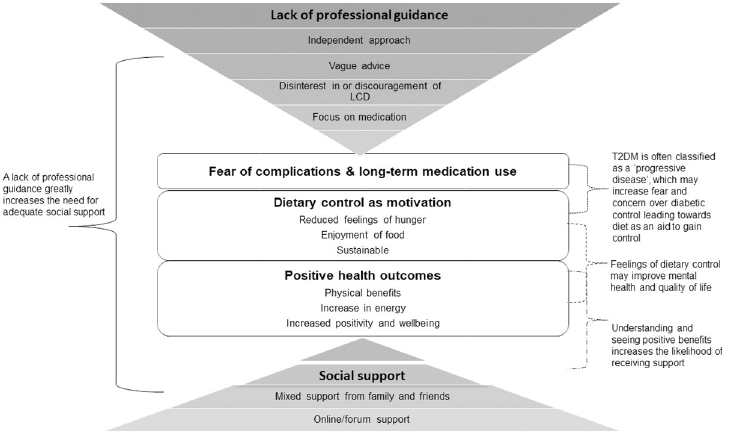
Fig 1. Relationship between key